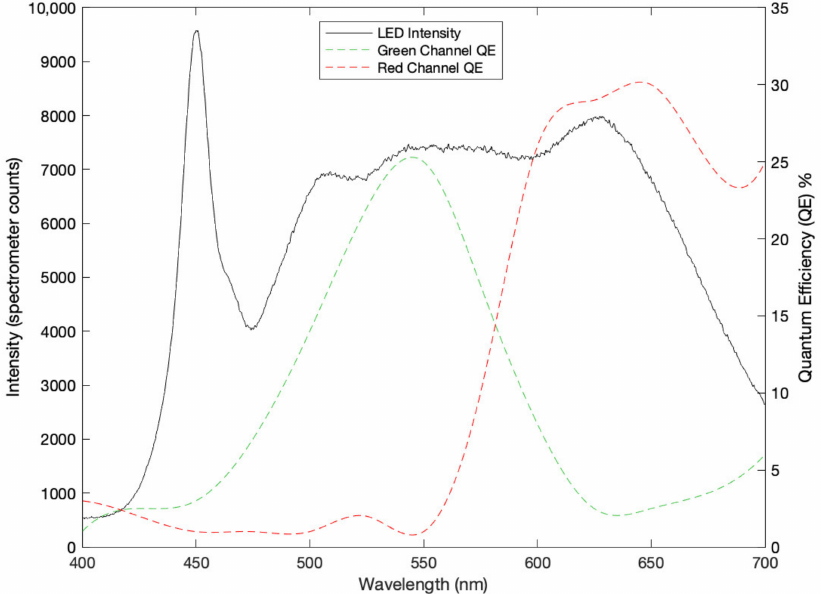
Figure 2. Relationship between the LED intensity (black line, with axis on the left), as measured by spectrometer counts, and quantum efficiency of the camera’s red and green channels (plotted in their own colors, with axis on the right), from 400–700